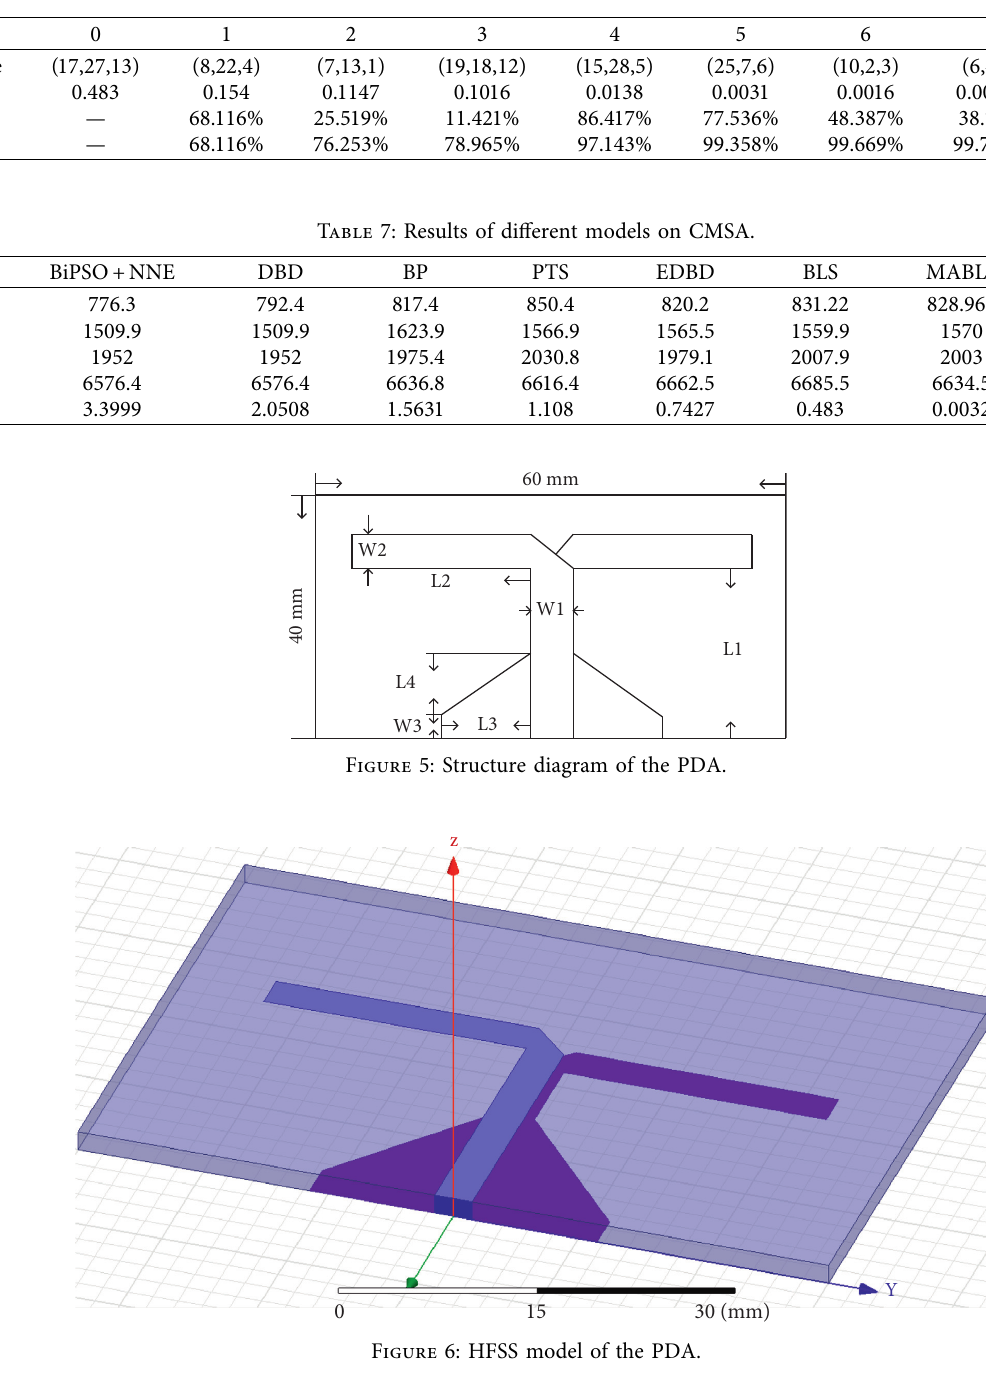
Table 6: AC iteration results on CMSA.